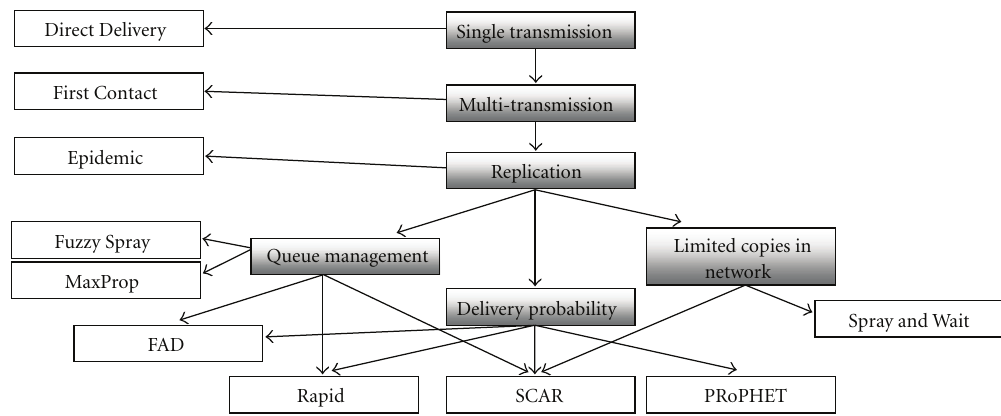
Figure 3: Map of most widely used DTN protocols.